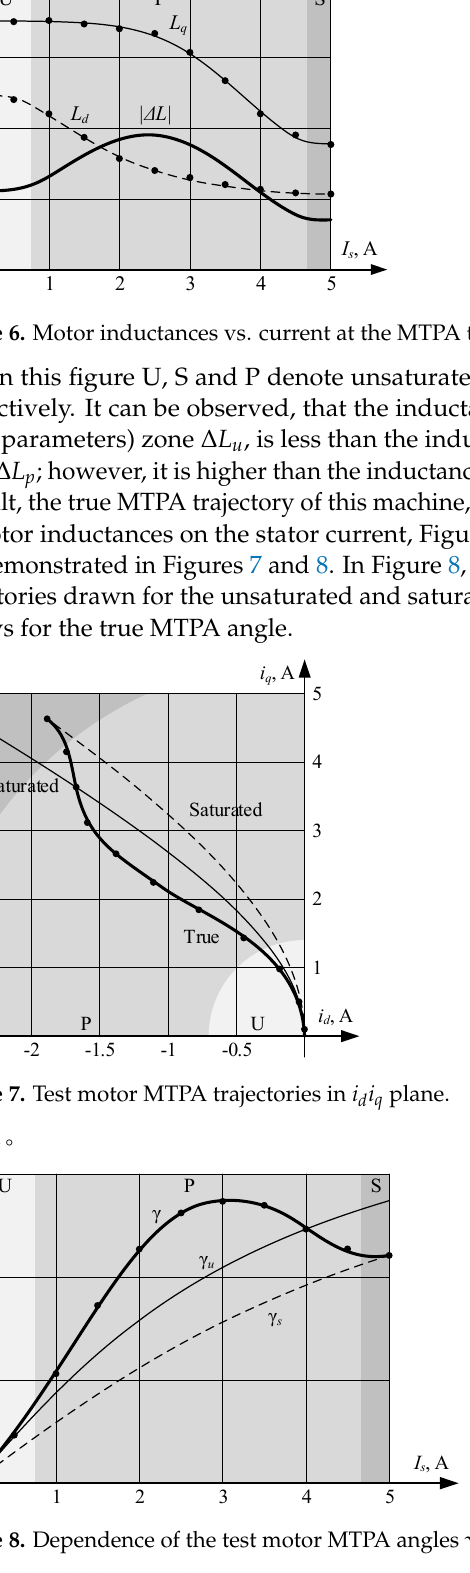
Figure 8. Dependence of the test motor MTPA angles γ with respect to the stator current amplitude.